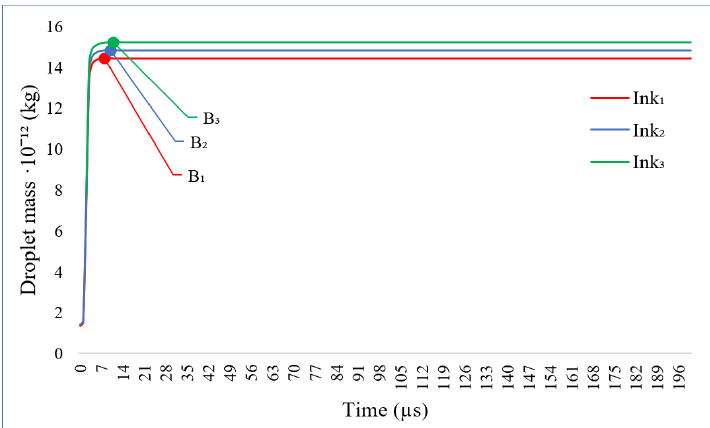
Figure 7. Representation of the mass of the droplets (Ink₁, Ink₂, Ink₃) versus time. Droplet mass is integrated over the computational domain. At point A, the droplet reaches its maximum velocity and the droplet mass starts to increase during the first period till it reaches point B. At point B, the droplet thread is pulled off from the printing nozzle and mass is fully given. Droplets of different inks increase very similarly (Ink₁ fully formed at 11 μs, Ink₂-13 μs, Ink₃-14 µs). When the liquid droplet is ejected, it needs a cer- tain time and distance to reach the full spherical form and during the impact, it will lose its spherical shape and take final form on the surface. All these depend on the ejecting parameters, droplet velocity, nozzle configurations, and liquid characteristics. In order to examine the differences between ink droplets, their mass can be addressed, which are: Ink₁ droplet 𝑚 𝑑 = 14.4·10 −12 kg, Ink₂ droplet 𝑚 𝑑 = 14.8·10 −12 kg, Ink₃ droplet 𝑚 𝑑 = 15.2·10 −12 kg. From this graphic, we can see that droplet mass stays fixed after point B when the droplet thread is pulled off. In the next graphic (Figure 8), droplet volume formation is demonstrated. Figure 8. Representation of the volume versus time of droplets of Ink₁, Ink₂, and Ink₃. Droplets reach their final volume at the same instance as already obtained for the mass. Inks with highest density and viscosity reach the largest volume: Ink₁ droplet 𝑉 𝑑 = 4.3491 pL, Ink₂ droplet 𝑉 𝑑 = 4.3493 pL, and Ink₃ droplet 𝑉 𝑑 = 4.3495 pL. B₁B₂B₃ 4.3364.3384.3404.3424.3444.3464.3484.3504.3524.3544.356 0 7 1 4 2 1 2 8 3 5 4 2 4 9 5 6 6 3 7 0 7 7 8 4 9 1 9 8 10 5 11 2 11 9 12 6 13 3 14 0 14 7 15 4 16 1 16 8 17 5 18 2 18 9 19 6 V o l u m e ( p L )